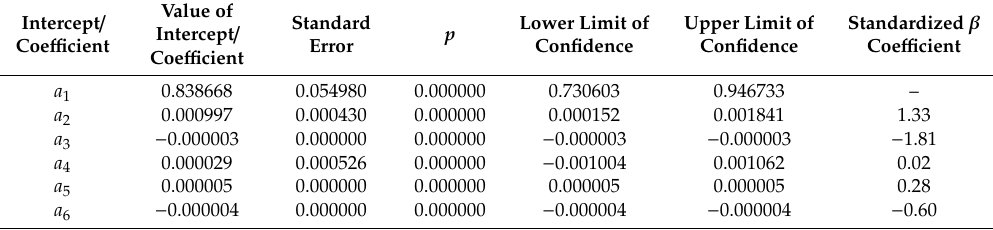
Table 5. Statistical evaluation of the combustible part ( CP ) model of torrefied pruned biomass.